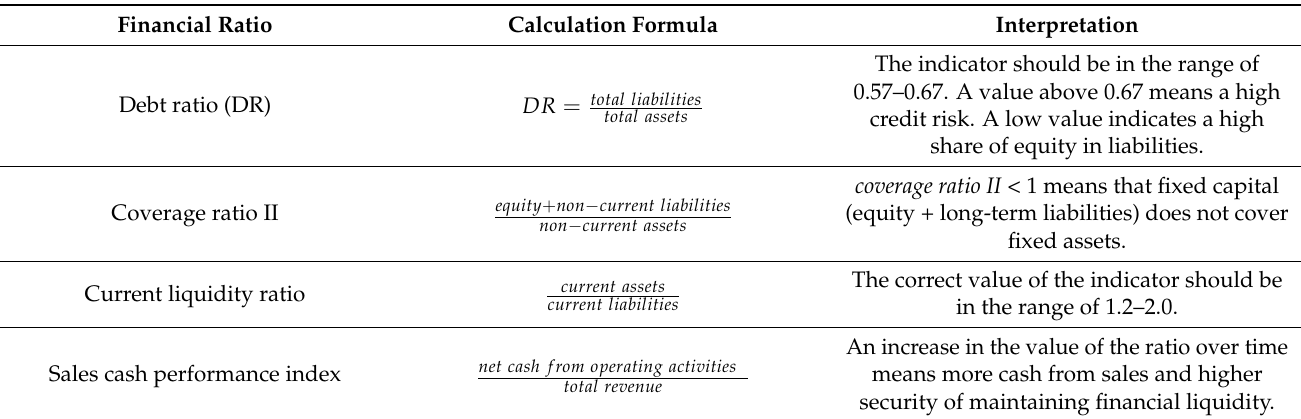
Table A2. Financial indicators—calculation formula and